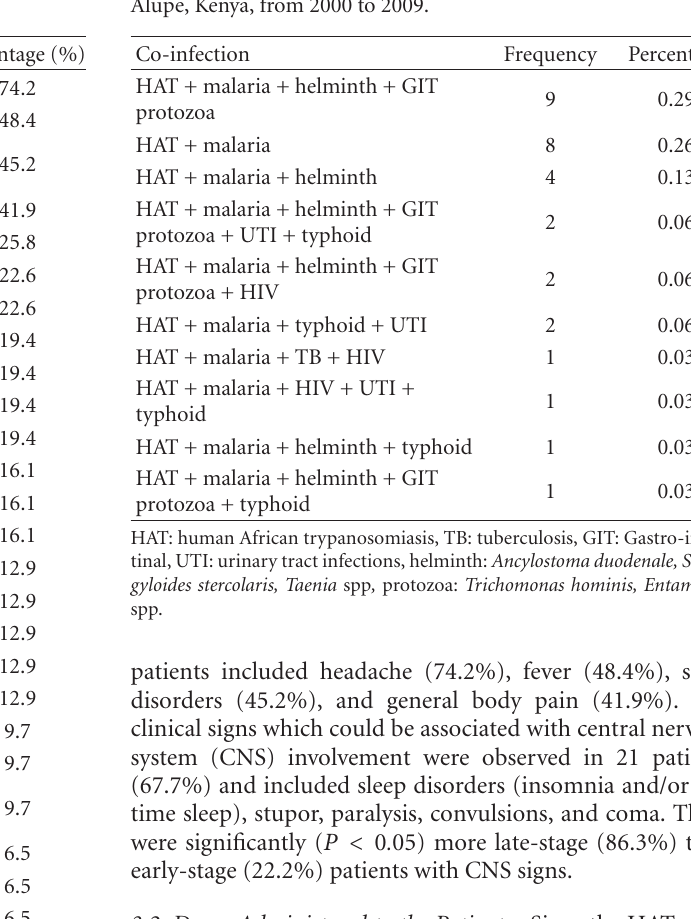
Table 2: Clinical signs observed in patients at the point of admis- sion at NSSRH, Alupe, Kenya, from 2000 to 2009.